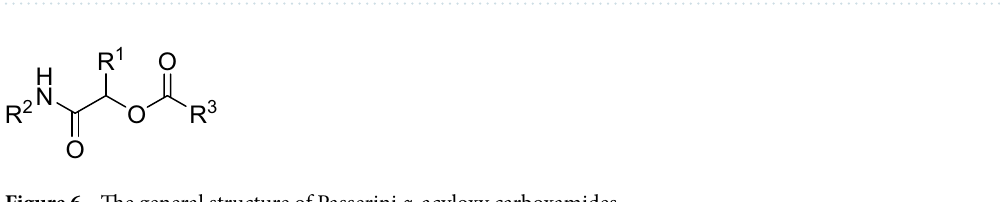
Figure 6. The general structure of Passerini α-acyloxy